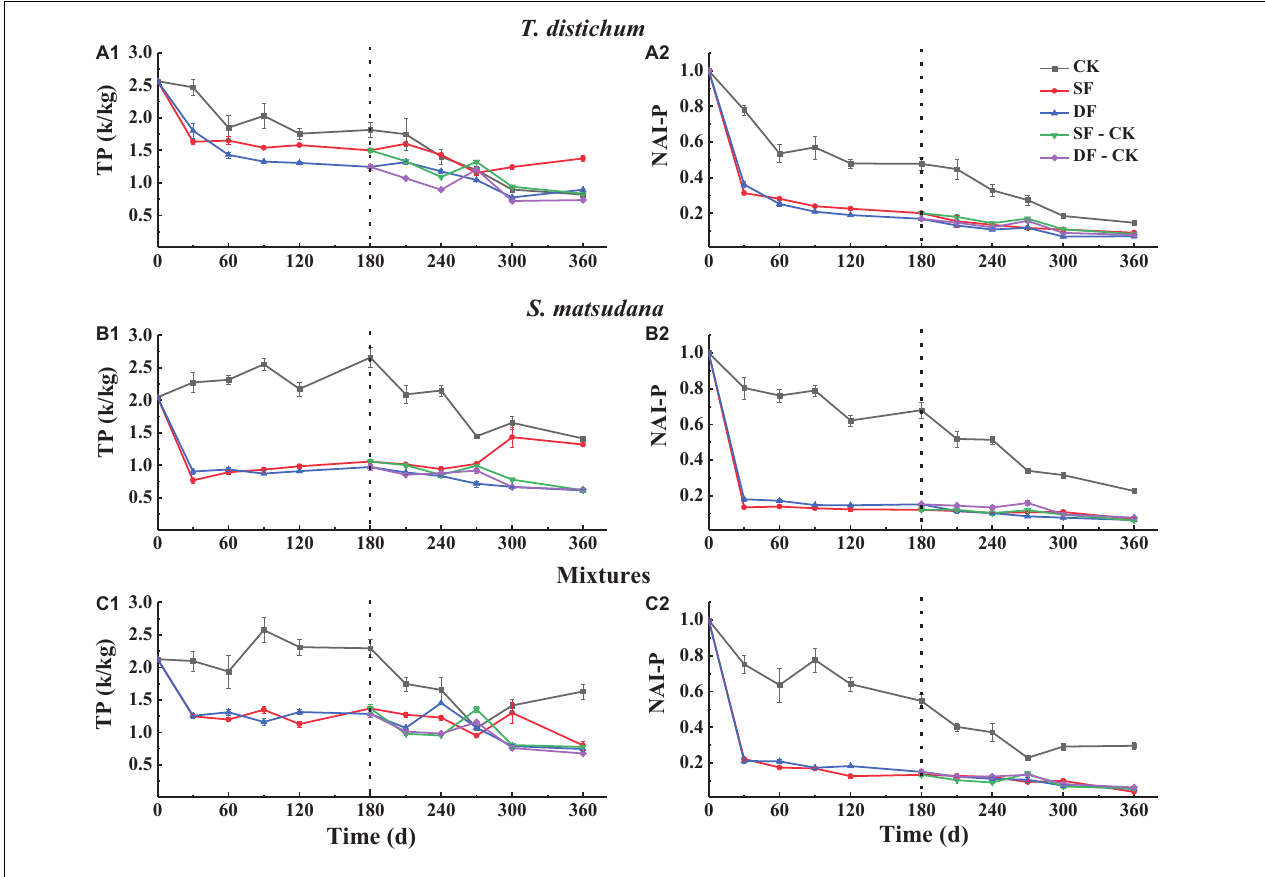
FIGURE 5 | The variation of total phosphorus concentration (A1–C1) and NAI-P index (A2–C2) during the process of foliage decomposition. CK, unflooded; SF, shallow flooding; DF, deep flooding; SF-CK, first half a year SF followed by half a year CK; DF-CK, first half a year DF followed by half a year CK.